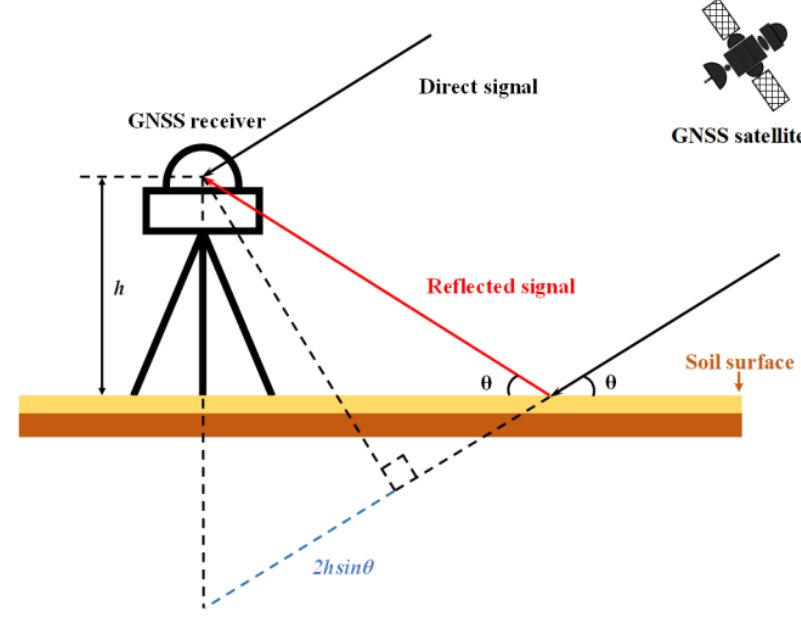
Figure 3. Schematic diagram of soil moisture monitoring by GNSS.